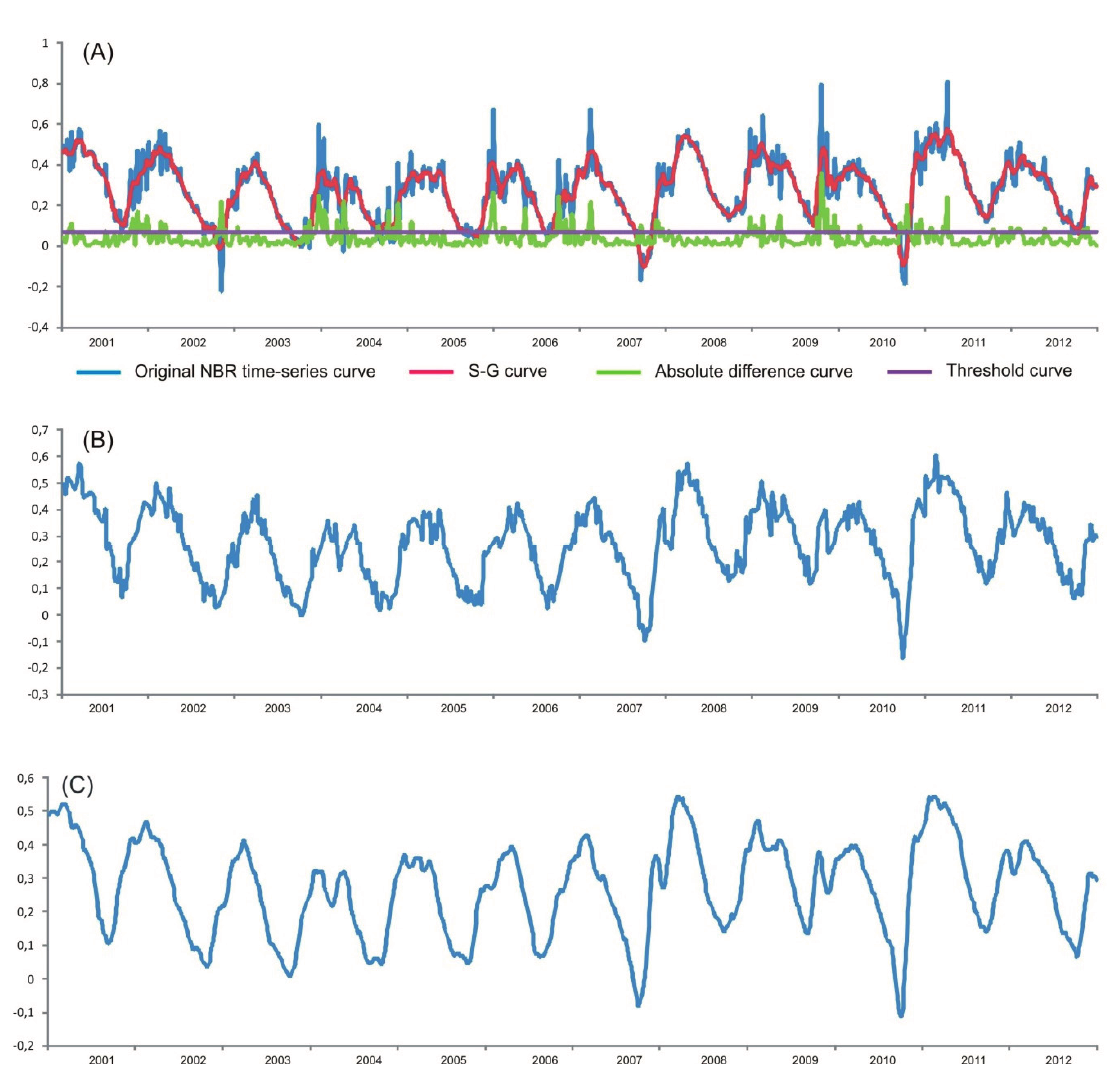
Figure 5 . Procedures for reconstruction of a NBR-MODIS time series using two-step filtering approach through the S-G method. ( A ) Outlier detection using the absolute value of the difference between the original data and the S-G curve (distance threshold of 0.07). ( B ) Time-series curve with the outliers replaced by a linearly interpolated value. ( C ) Time-series curve after the second filtering by S-G method (window size of